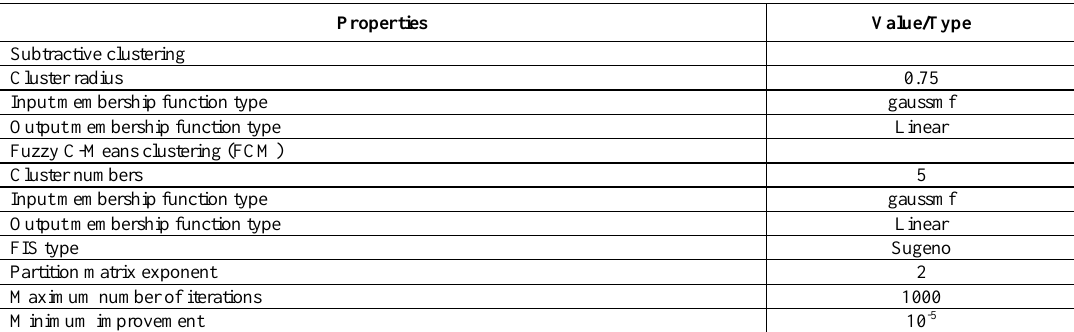
Table 4. Properties and parameter values of the constructed